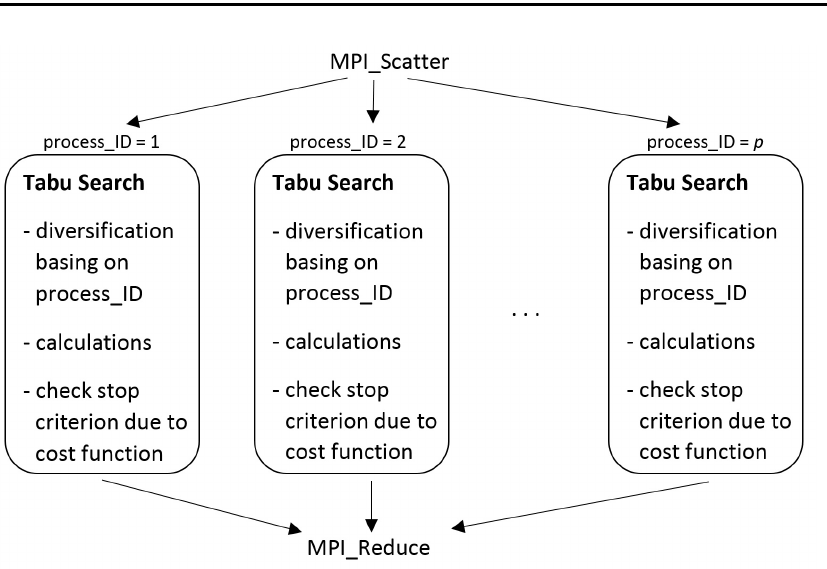
Figure 2. Tabu Search MWPTSA parallelization